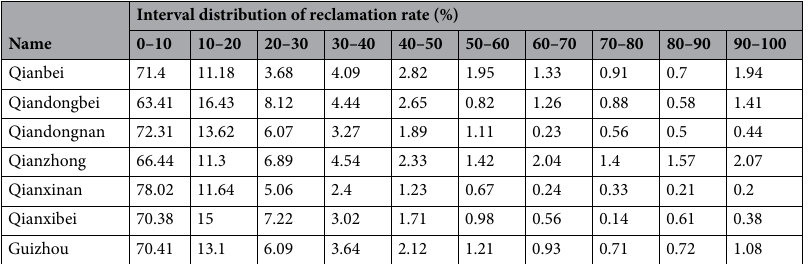
Table 5. Reconstruction result settlement rate interval